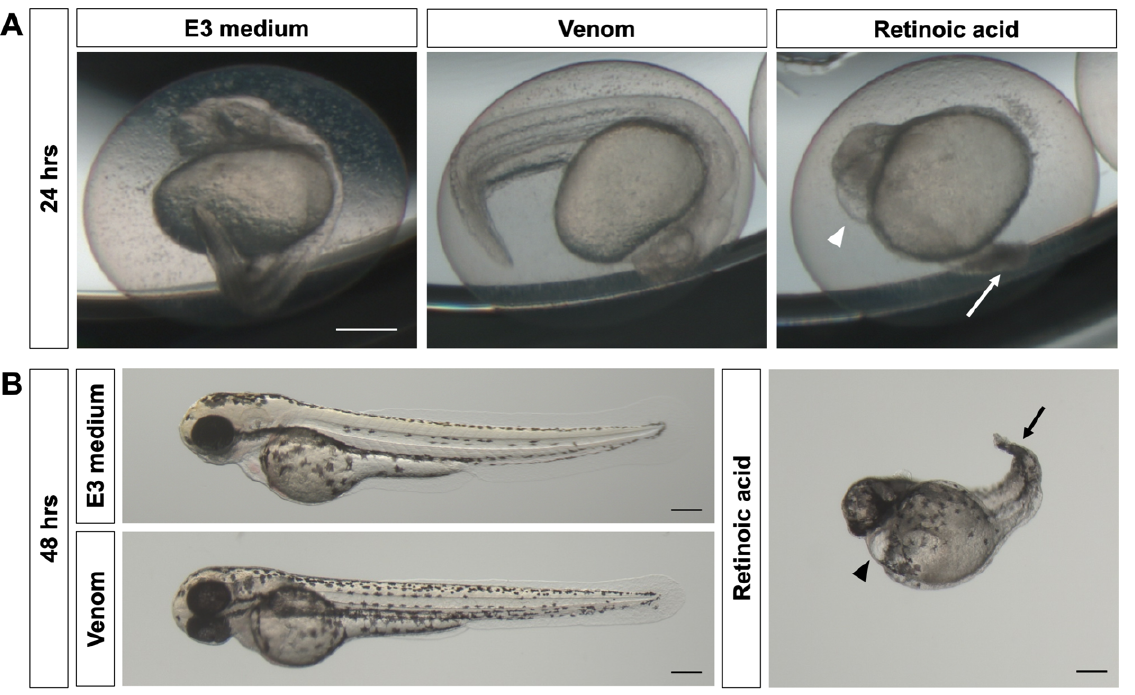
Figure 2. Lack of teratogenicity of M. bornmuelleri ’s venom on zebrafish embryos. Representative images of zebrafish embryos after ( A ) 24 and ( B ) 48 hrs of exposure to M. bornmuelleri ’s venom (1 mg/mL) showing no signs of teratogenicity. Embryos exposed to retinoic acid served as the positive control, showing signs of teratogenicity such as pericardial edema (arrowheads) and tail malformation (arrows). E3 medium was used as the negative control. Scale bar: 200 µ